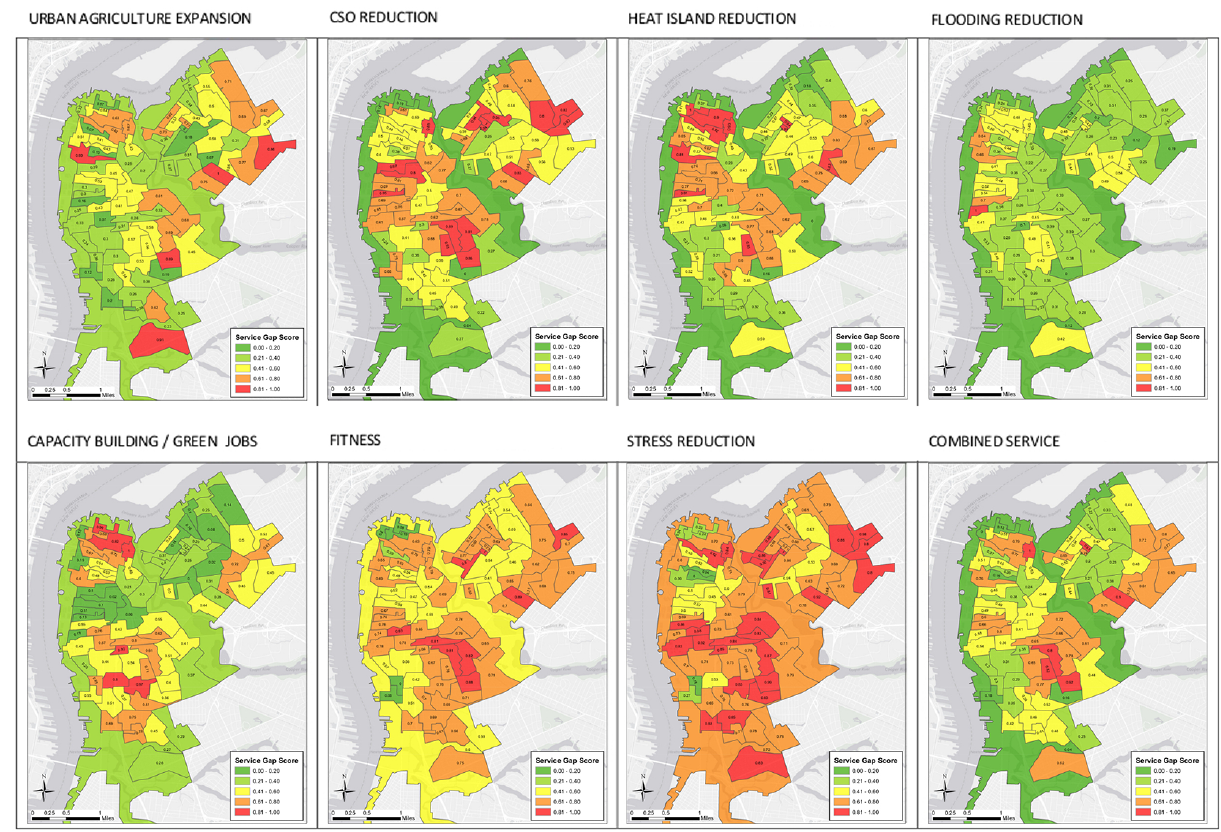
Figure 2. Individual gap score map for each ecosystem service evaluated.